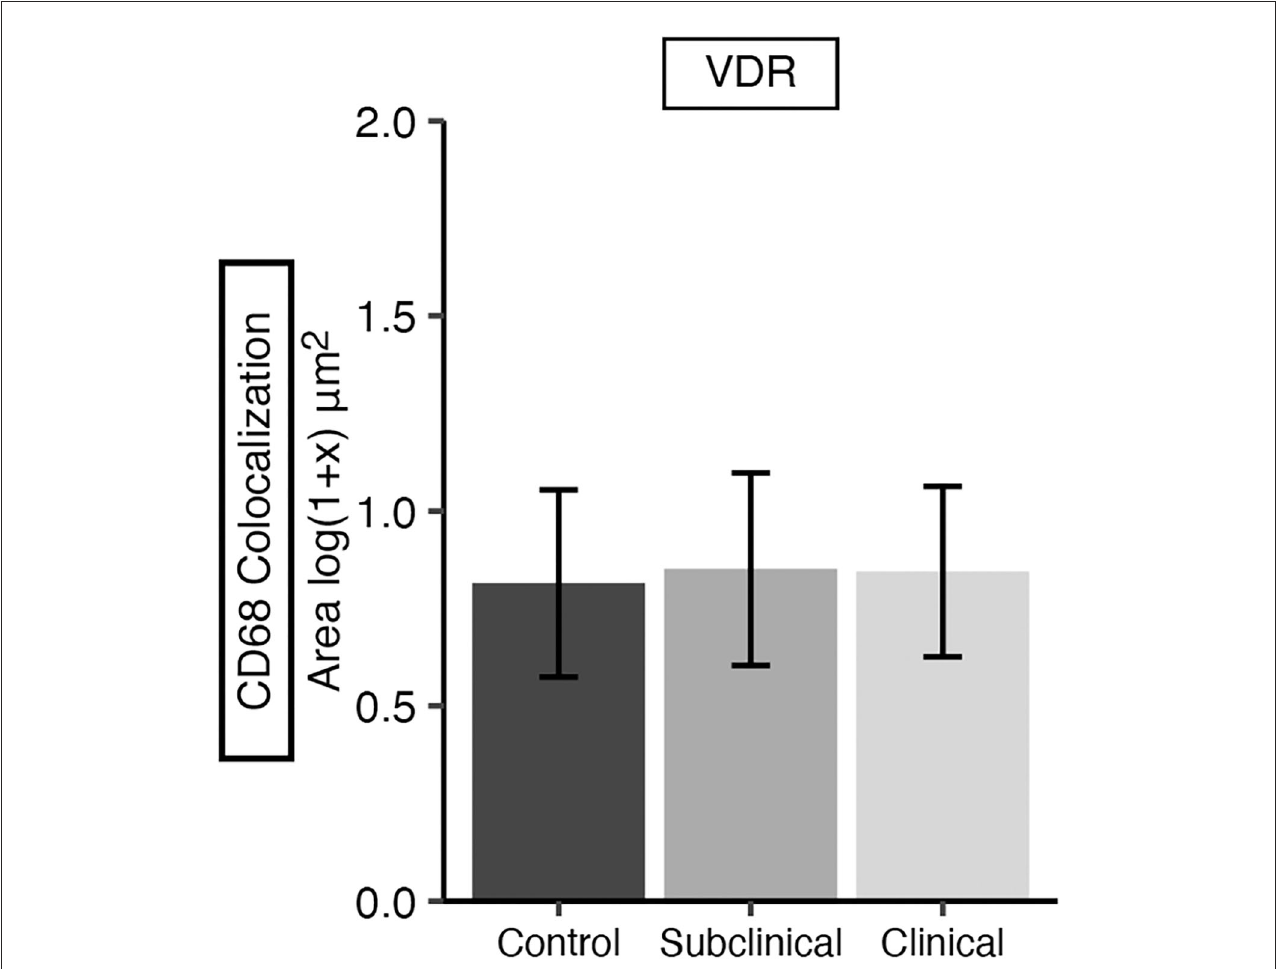
FIGURE9 Vitamin D receptor (VDR) expression in frozen tissue sections from bovine mid-ileum. Cows were grouped according to stage of paratuberculosis infection (clinical n = 9, subclinical n = 9, JD- control n = 8). VDR expression was measured within CD68 + macrophages and is presented as the mean fluorescence area [log(1 + x) µ m 2 ] ± SE. No significant differences were observed among infection status groups.